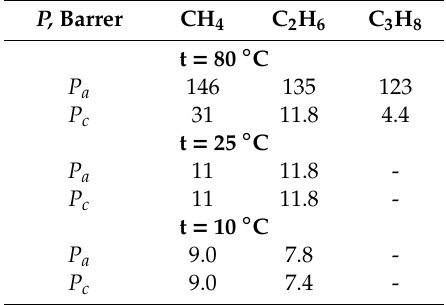
Table 4. The gas permeability coe ffi cients in the amorphous ( P a ) and crystalline ( P c ) phases of PMPentene at di ff erent temperatures.